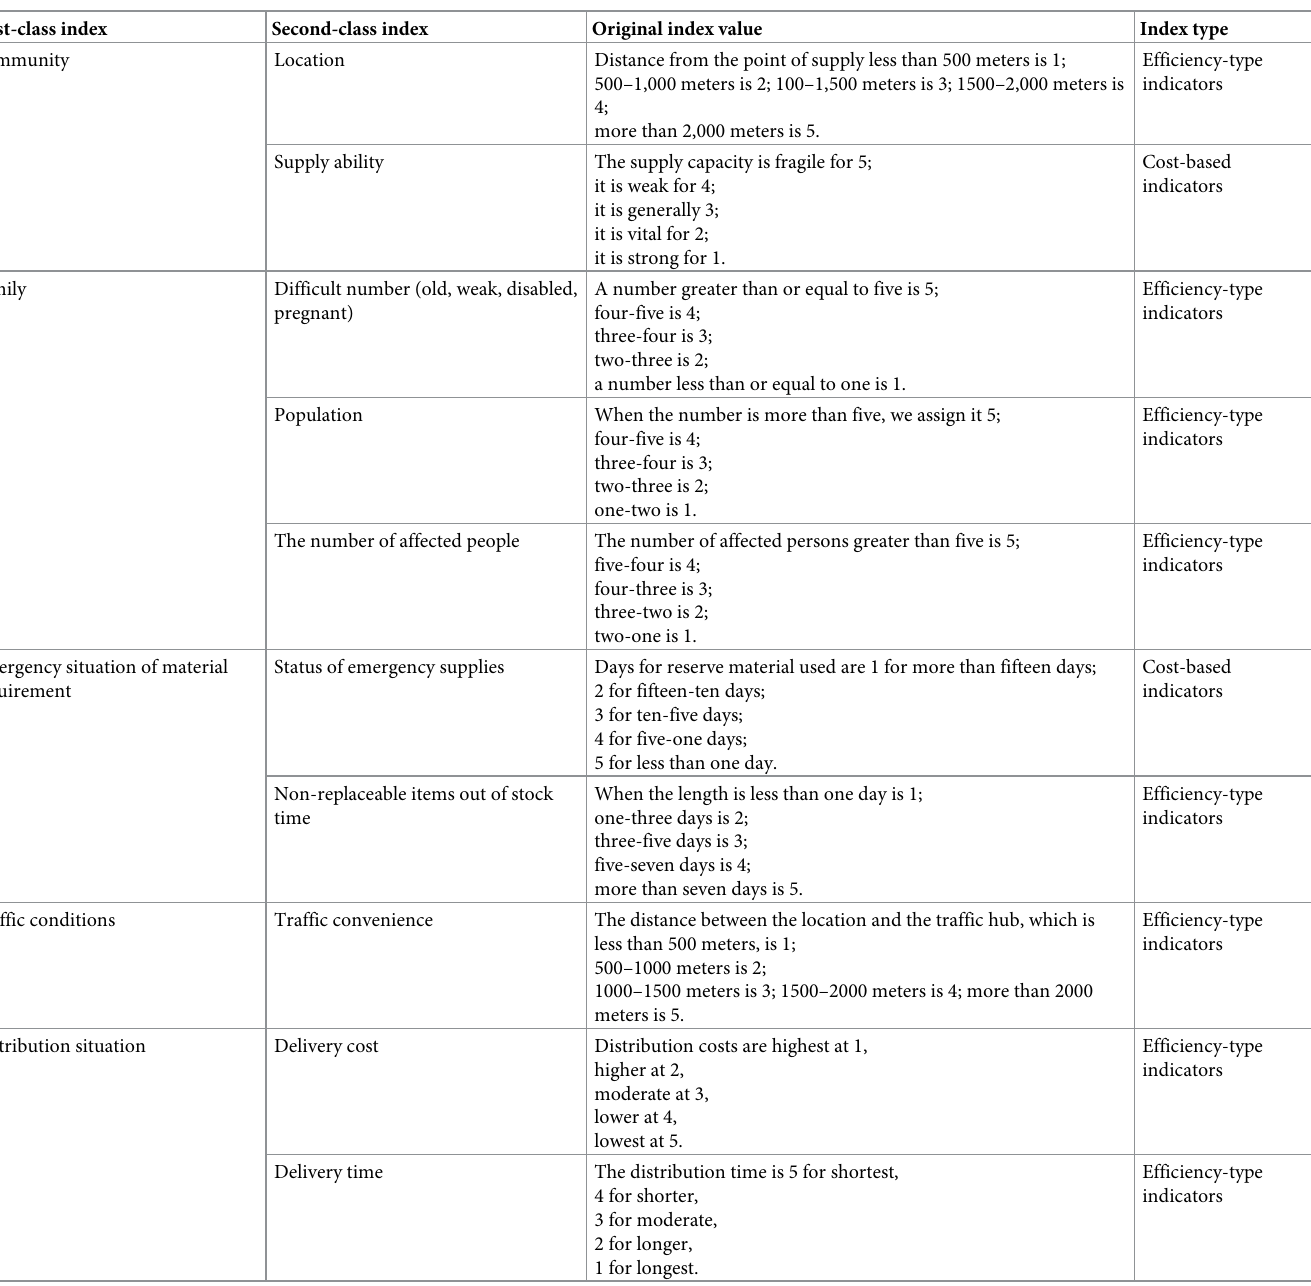
Table 2. The demand side establishes the indicator